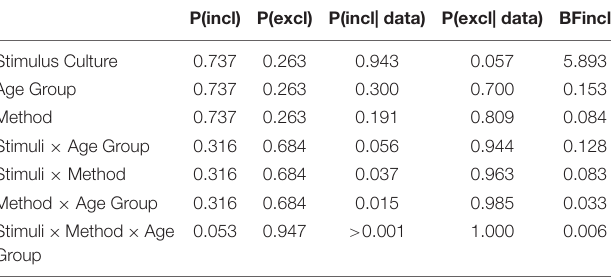
TABLE 3 | Evidence for the presence of particular effects in the accuracy of the visual task (Data averaged over all the models including/excluding a particular predictor).